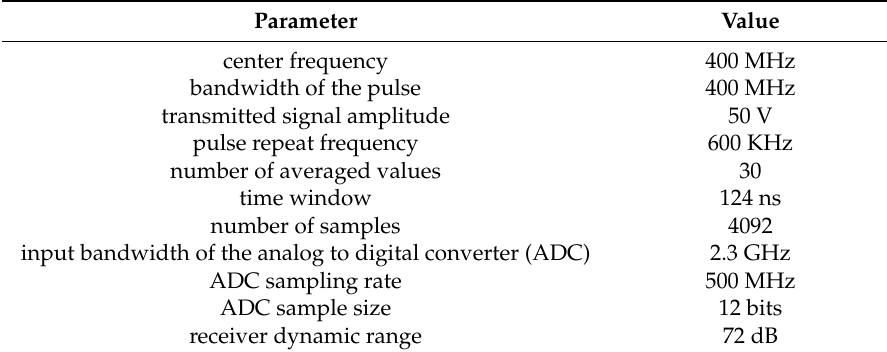
Table 1. Parameters for the ultra-wideband (UWB) impulse